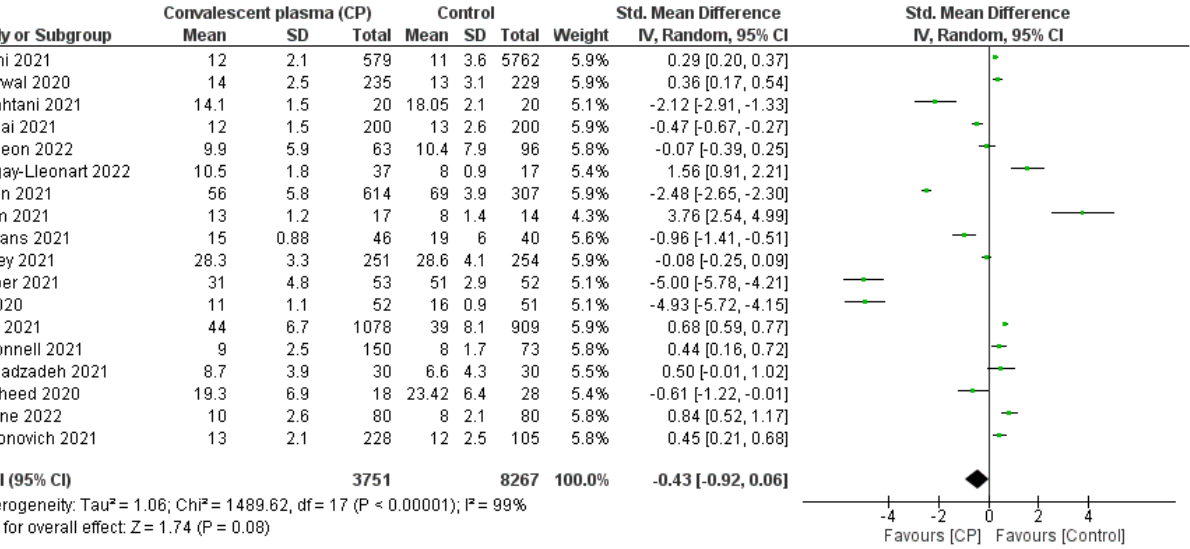
Figure 3. Comparison of reduction in hospitalization length (days) between CP transfusion and control groups [8,14,16,18–20,24,25,29,32,36–38,41–43,45]; ( ) SMD of individual studies; ( ) SMD summary of the comparison.